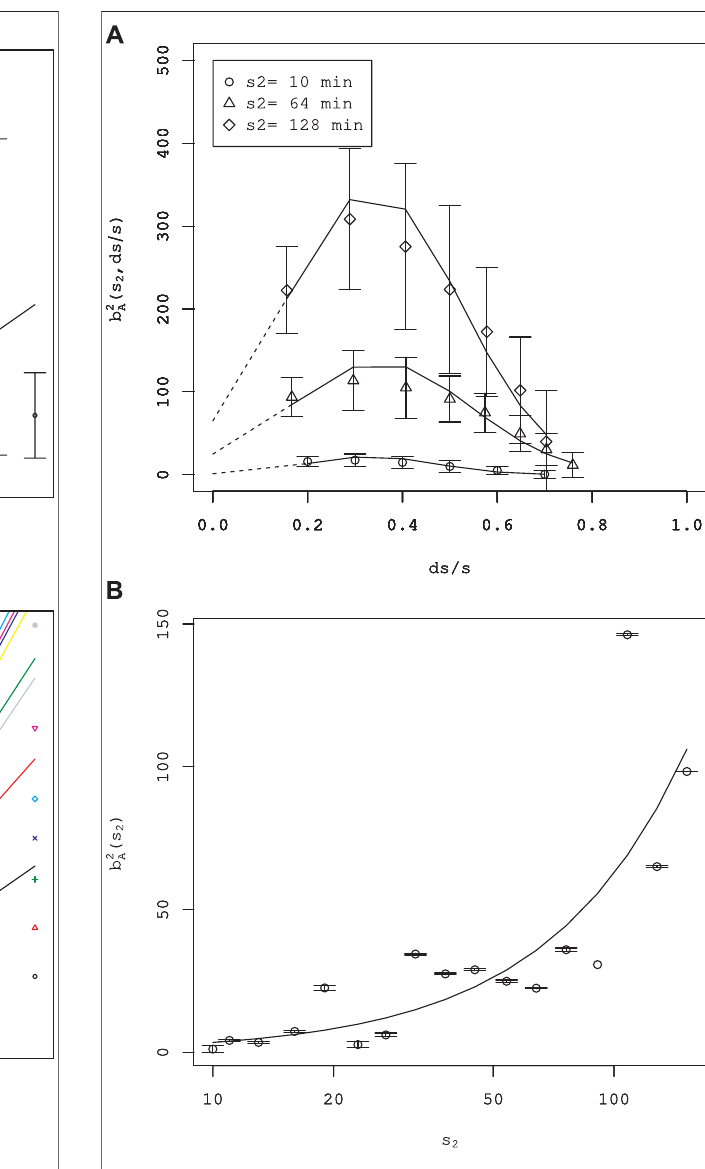
FIGURE 6 | Regression of E (( x 1 − x 2 )| x 2 (cid:2) x ) / ( λ 1 − λ 2 ) against x 2 . (A) Standarderrorsaredenoted byanerror bar. (B) Fitting isapplied tovarious s 1 and s 2